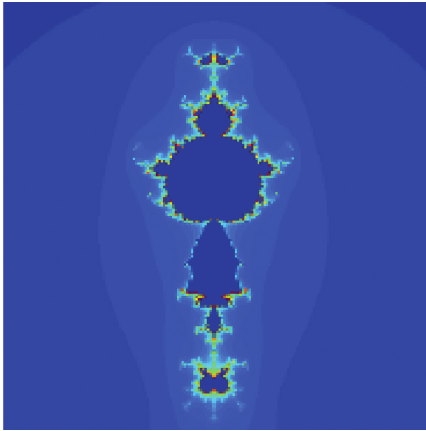
for the critical point 3